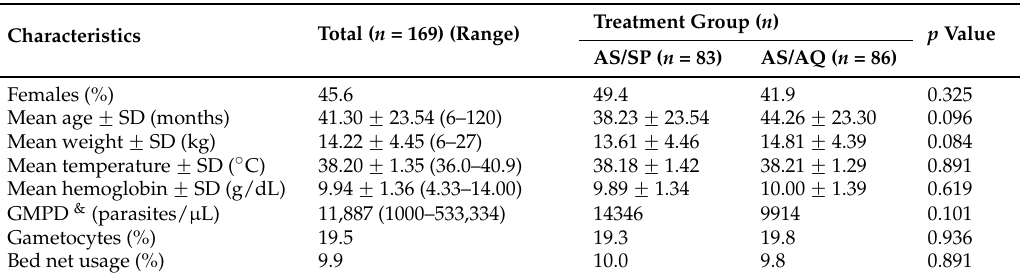
Figure 1. Trial profile. Screening, enrollment, and follow-up of patients. Table 1. Baseline characteristics of enrolled patients, stratified by drug